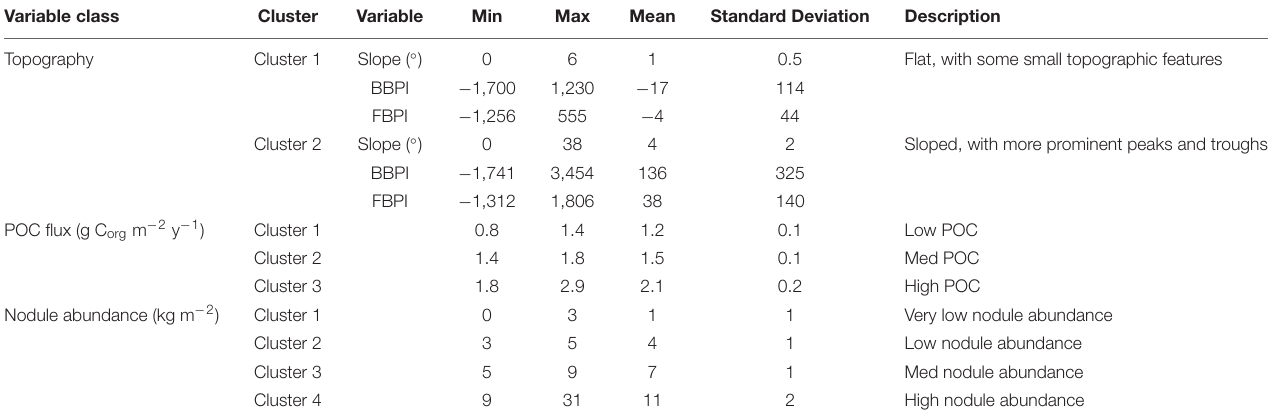
TABLE 2 | Properties of clusters selected for the final habitat classification, produced through CLARA clustering of environmental surrogates. Variable